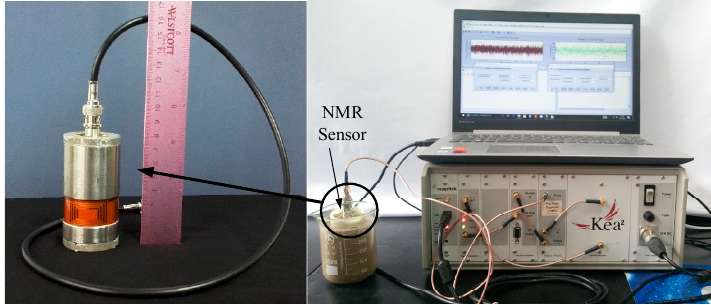
Figure 8. Measurement system.